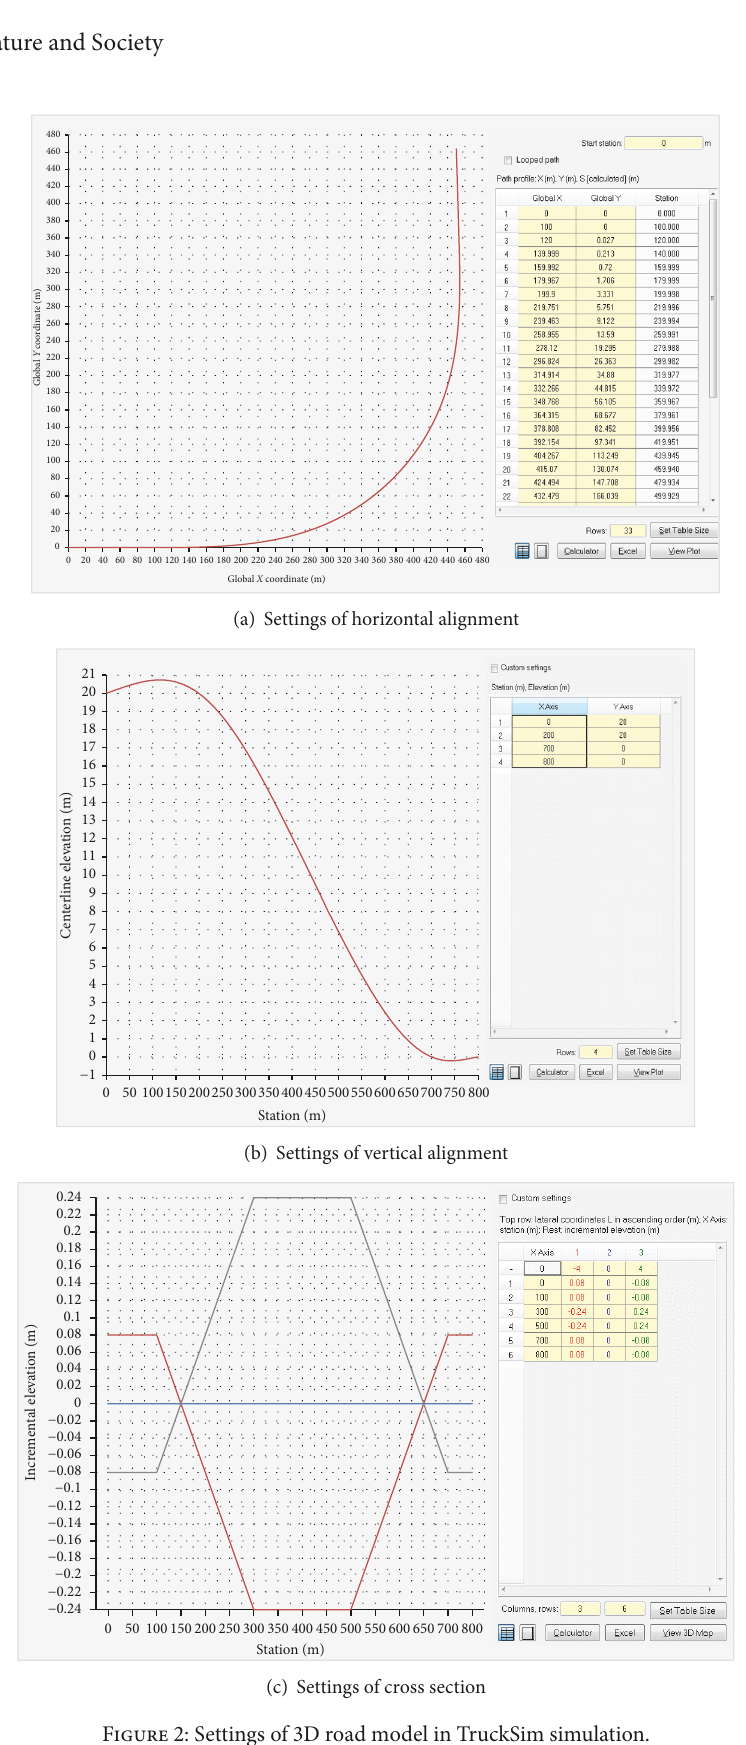
Figure 2: Settings of 3D road model in TruckSim